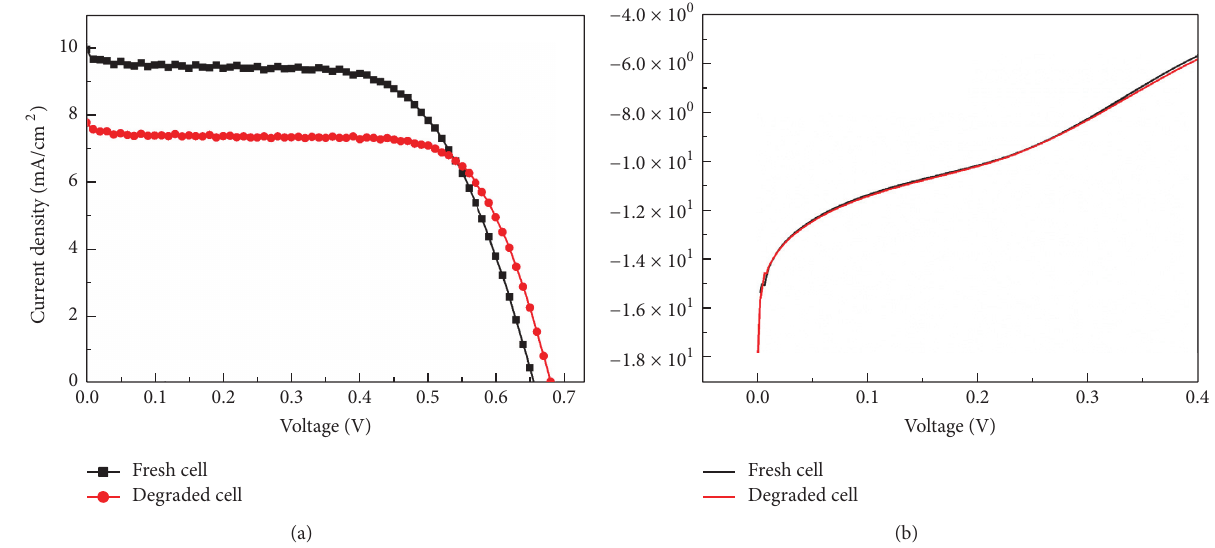
Figure 2: (a) Current density-voltage ( J-V ) characteristics of fresh DSC and degraded DSC. (b) Dark J-V for fresh and degraded DSC.